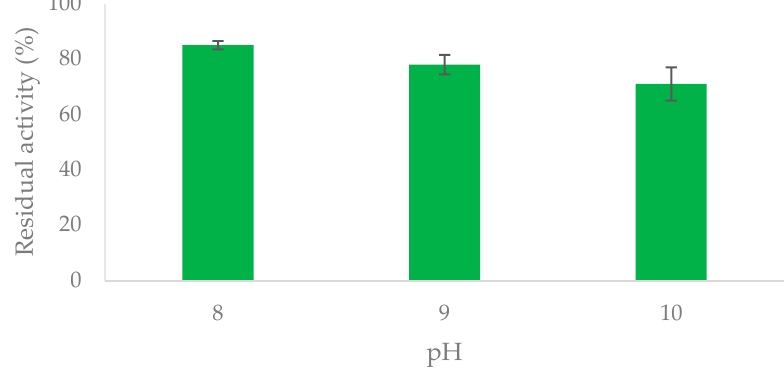
Figure 1. Residual activity (%) of soluble OYE3 upon incubation at pH 8–10 (endpoint—3 h). Experimental conditions: 50 mM phosphate buffer, pH 8; 50 mM Tris-HCl buffer, pH 9; 50 mM NaOH-glycine buffer, pH 10; 20 °C. Enzyme activity was determined as reported in Scheme 1. Residual activity (%) was calculated as reported in paragraph 3.5 [29].